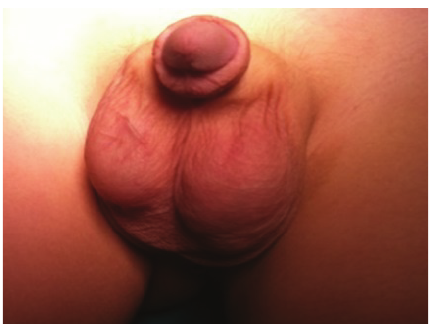
Figure 2: Asymmetrical testicles.